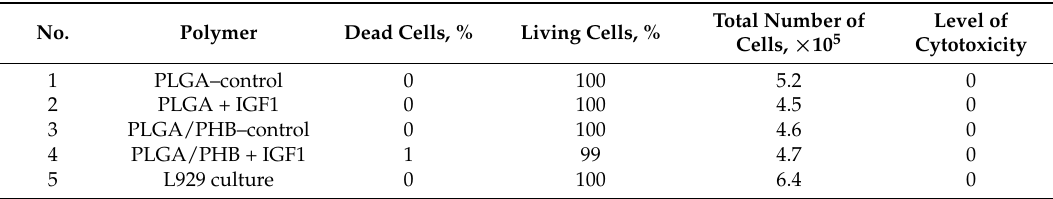
Table 7. Number of cells and level of cytotoxicity after 72 h of incubation—indirect method (nonpolar extract).